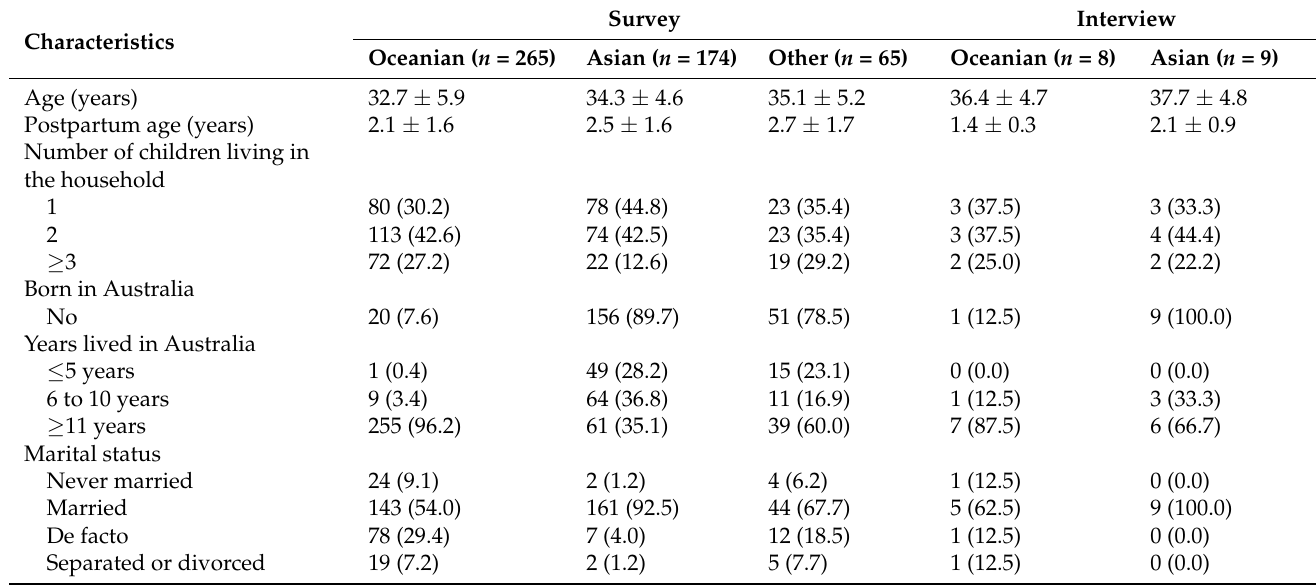
Table 1. Demographic characteristics of survey and interview